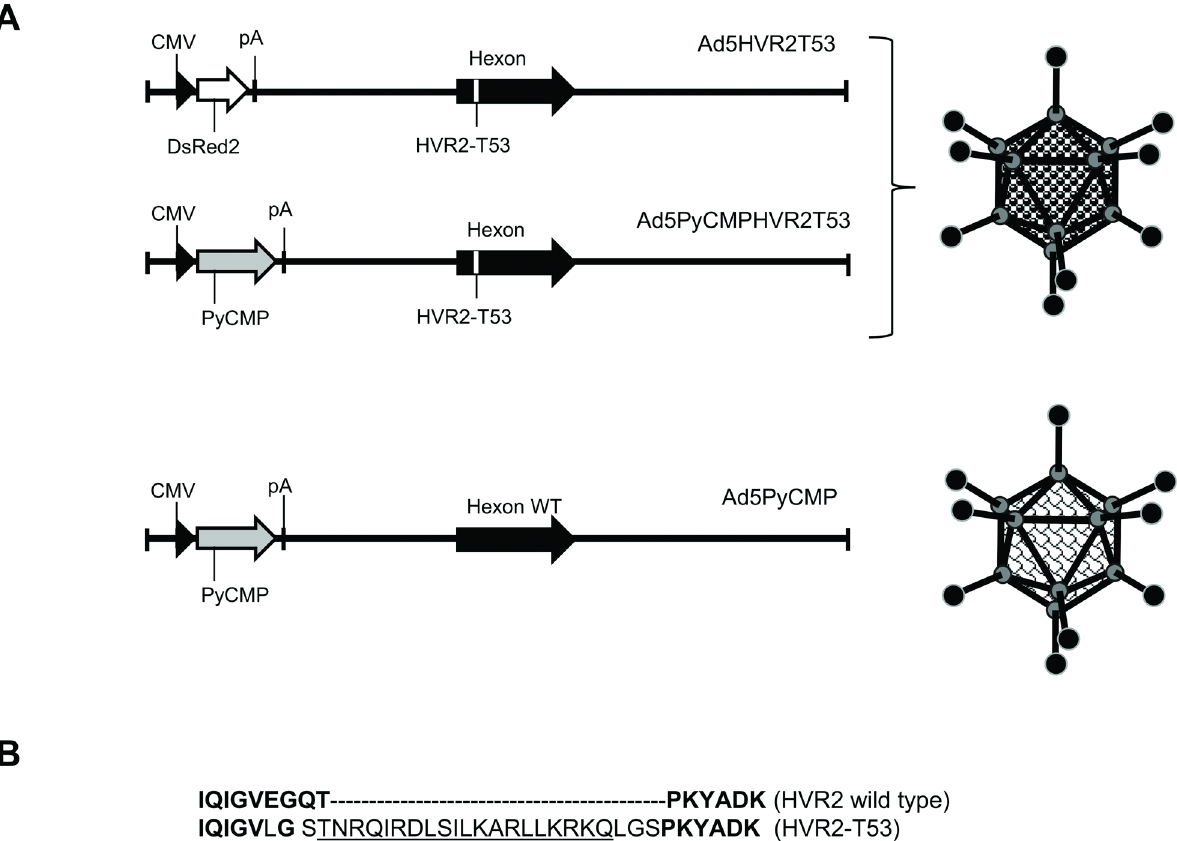
Fig 1. Schematic representation of the generated Ad5 vectors. (A) The Ad5HVR2T53 genome was constructed to incorporate the CMV promoter-driven red fluorescent DsRed2 protein gene followed by the Simian Virus 40 (SV40) polyadenylation signal ( pA ) in place of the deleted early E1 region. The Ad5HVR2T53PyCMP and Ad5PyCMP vectors contain the CMV promoter-driven gene encoding a Plasmodium yoelii chimeric multistage protein, PyCMP , in place of E1 . In Ad5HVR2T53 and Ad5HVR2T53PyCMP vector, the sequence encoding hyper-variable region 2 (HVR2) of hexon gene was altered to incorporate a promiscuous Plasmodium yoelii T cell epitope (PyT53) (B). The amino acid sequence alignment showing wild type HVR2 (in bold) in the upper row aligned with HVR2 incorporating T53 epitope (underlined) in the lower